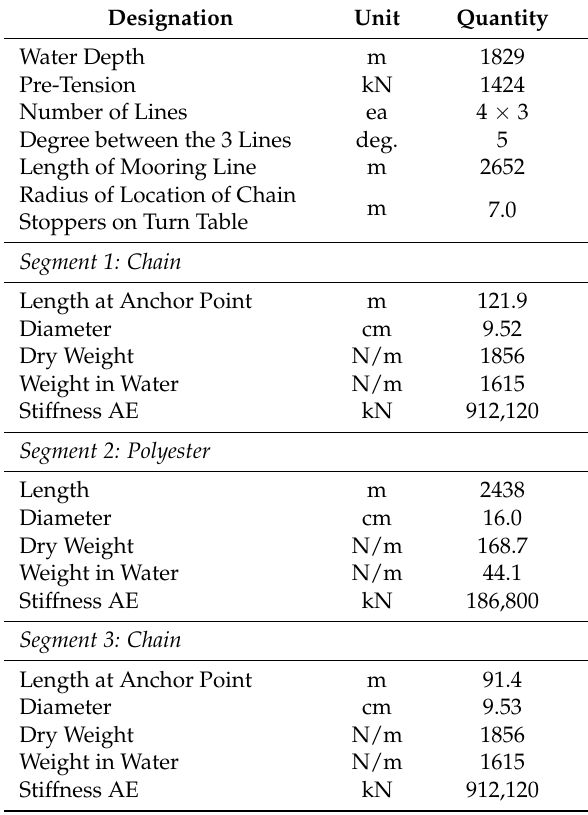
Figure 11. Arrangement and Numbering of the FPSO Mooring Lines. Table 5. Mooring Line